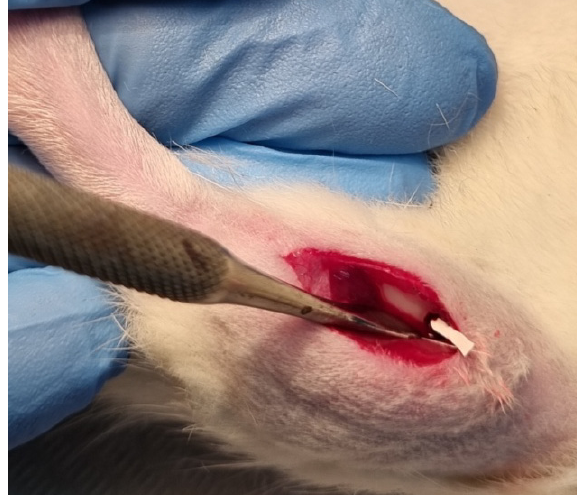
Figure 13. In vivo procedure: A laminar chitosan–silica biocomposite implant being placed through a hole in the tibial medullary